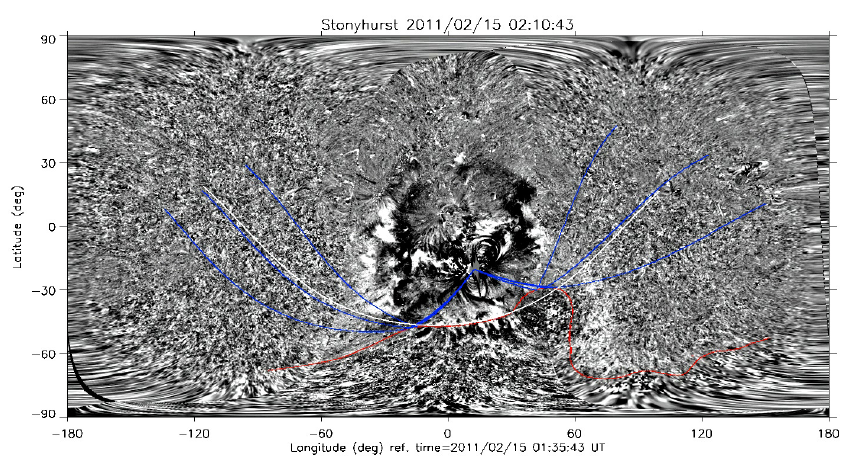
Figure 31: Still from a movie – An animation of the 2011 Feb 15 coronal wave and its reflection on a coronal hole as seen on a full sun map combining EUVI-A and EUVI-B (195 ˚A) with AIA (193 ˚A) data. Shown is a sequence of running ratio images. The blue lines indicate the predicted wave trajectories and clearly show the reflection at the coronal hole boundary (red line). Reproduced with permission from Olmedo et al. (2012), copyright by AAS. (To watch the movie, please go to the online version of this review article at http://www.livingreviews.org/lrsp-2015-3